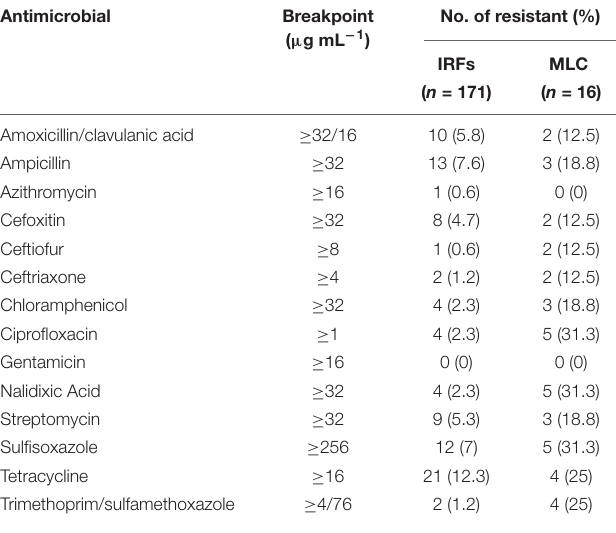
TABLE 4 | Antimicrobial resistance of E. coli isolates from the irrigation return flows (IRFs) and background canal site (MLC).